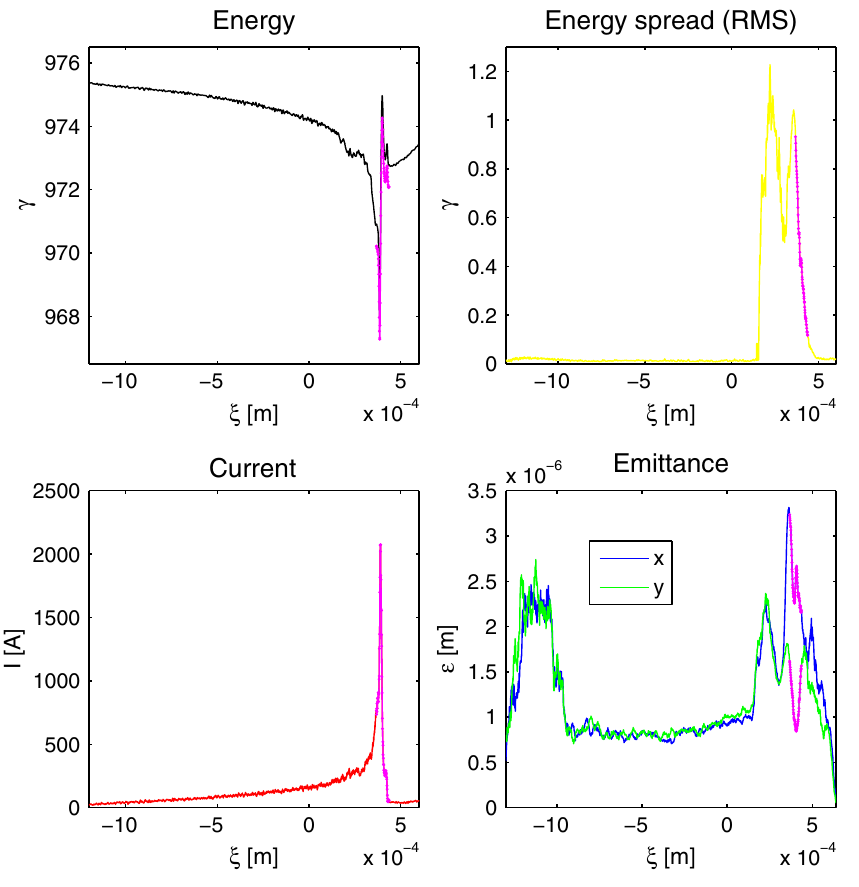
FIG. 2. (Color) Electron beam properties at the undulator entrance obtained from start-to-end simulations. Only the part marked by the magenta dots produces FEL radiation.